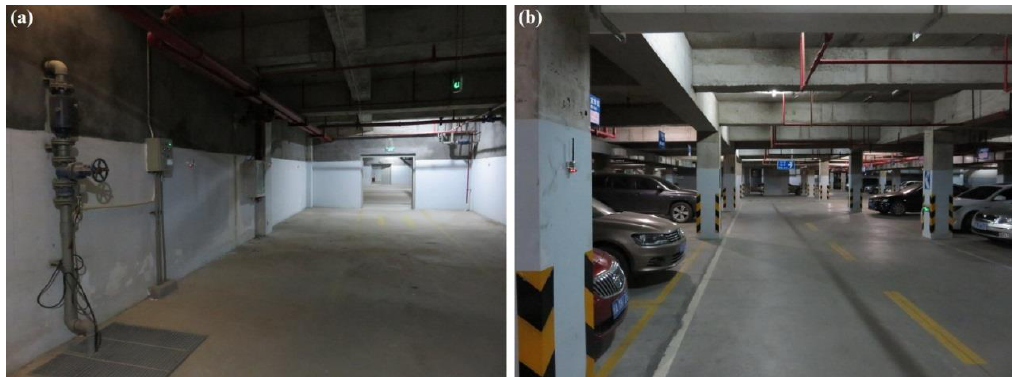
Figure 17. ( a ) Illustration of testing scenario 2; ( b ) Illustration of testing scenario 3.